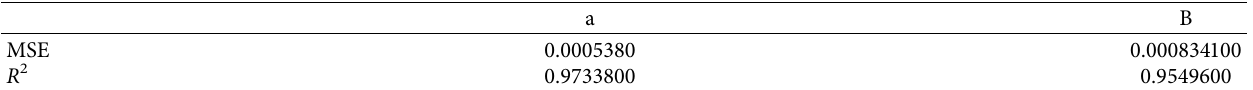
Figure 4: The output result table of the ELM algorithm. (a) The mean square error (MSE) of the prediction result and (b) goodness of fit ( R 2 ). Table 1: The output error of the ELM